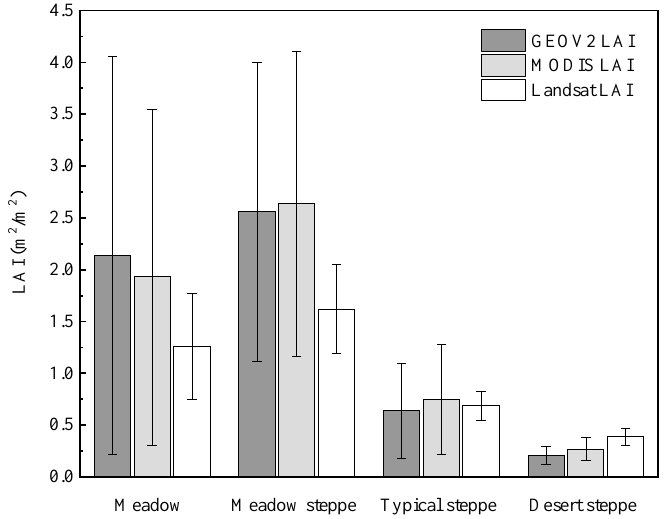
Figure 8. Intercomparison of grassland LAI in the four scenes among MODIS LAI, GEOV2 LAI and Landsat LAI, showing mean and standard deviation.